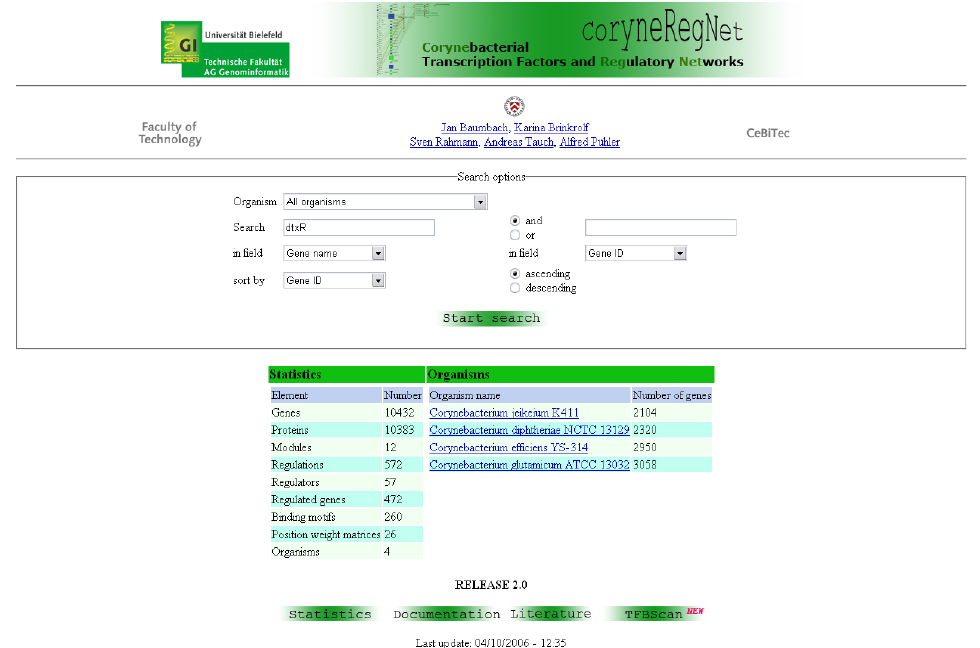
Figure 2: The initial search mask of CoryneRegNet 2 contains organism statistics. Another new feature is the TFBScan button in the lower right corner.